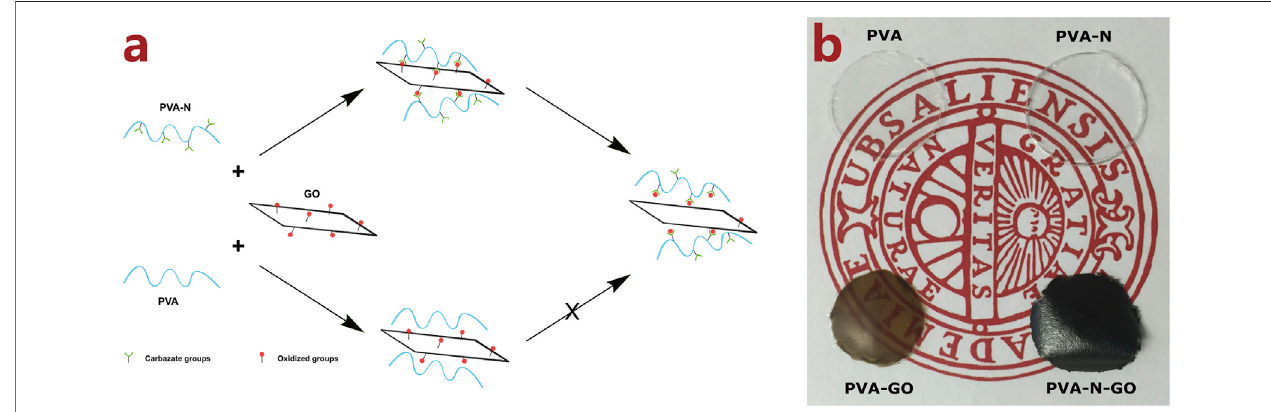
FIGURE1| SchematicillustrationofthepreparationofPVAandPVA-NnanocompositeswithGOafterthermaltreatment (A) ,andthepictureofPVA,PVA-N,PVA- GO, and PVA-N-GO with the logo of Uppsala University (B) .